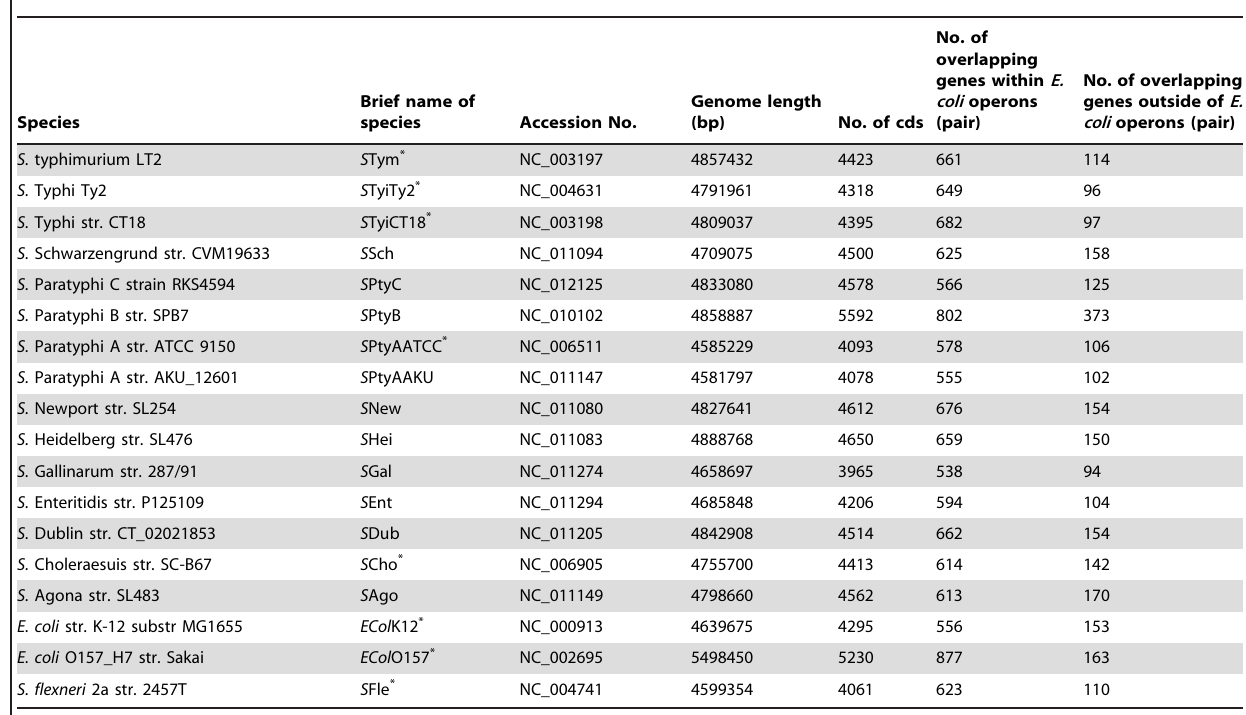
Table 1. Completely sequenced genomes analyzed in this study.